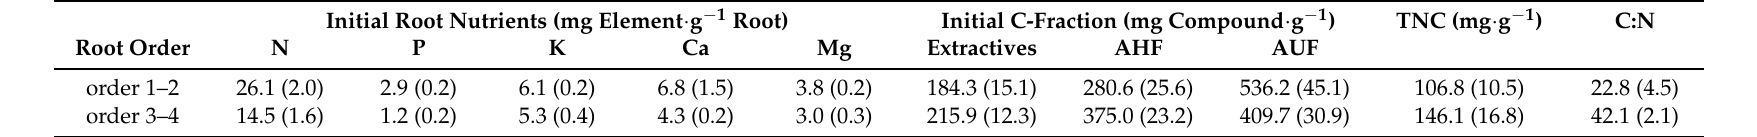
Table 1. Initial root chemistry parameters (means and SE) at the start of the litterbag experiment of Larix gmelinii